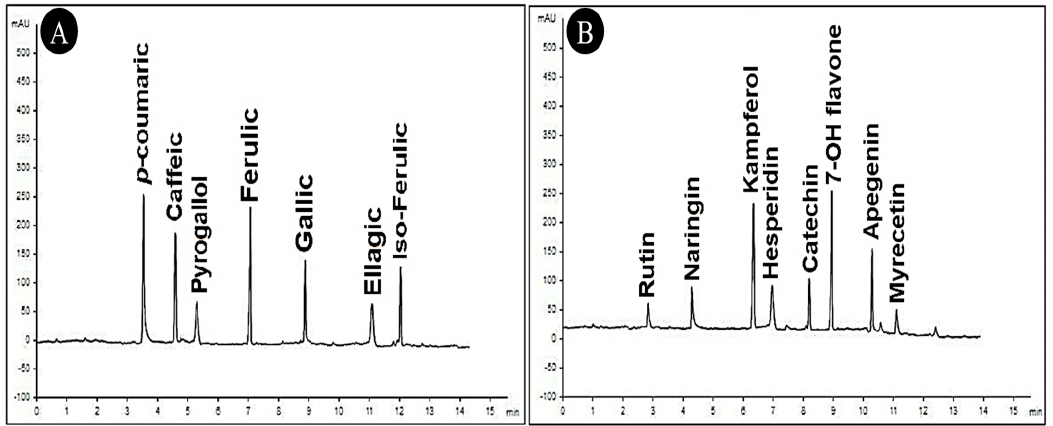
Figure 9. HPLC chromatograms of the phenolic ( A ) and flavonoid ( B ) chromatograms identified in Chorisia speciosa extract. Table 3. Polyphenolic compounds identified in Chorisia speciosa extract.